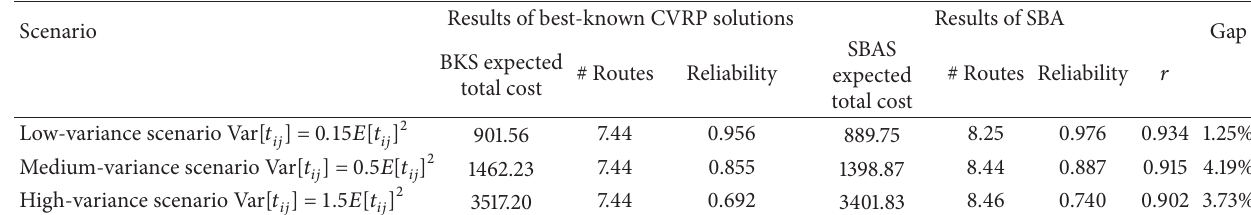
Table 3: Average results of the 59 instances for three different